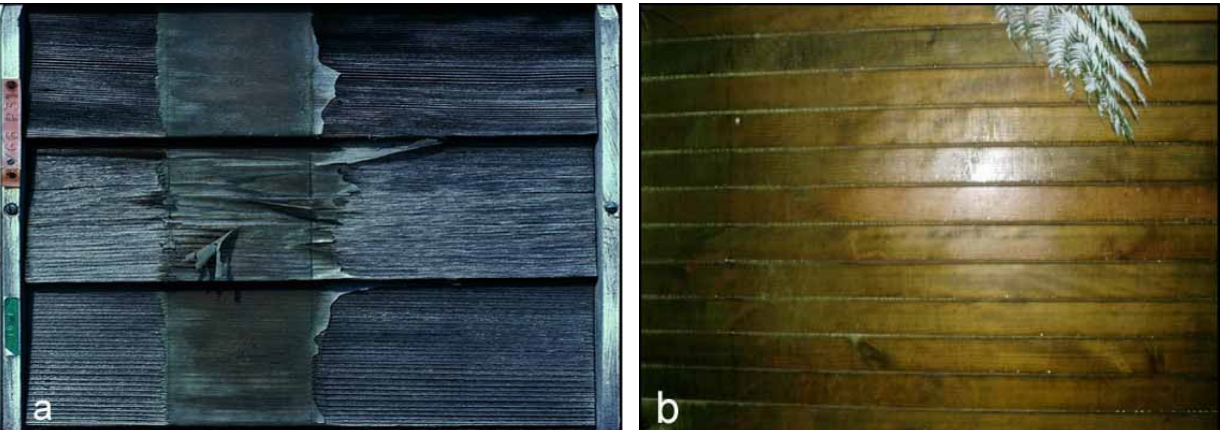
Figure 9. Effect of chromium VI pre-treatment on the performance of clear finishes